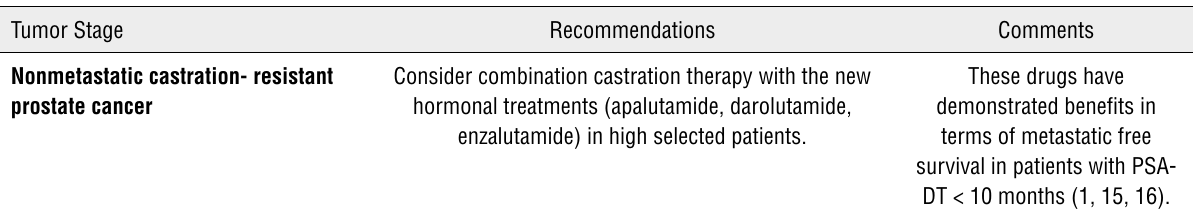
Table 3 - Management of non metastatic castration- resistant PCa during the COVID-19 era. Tumor Stage